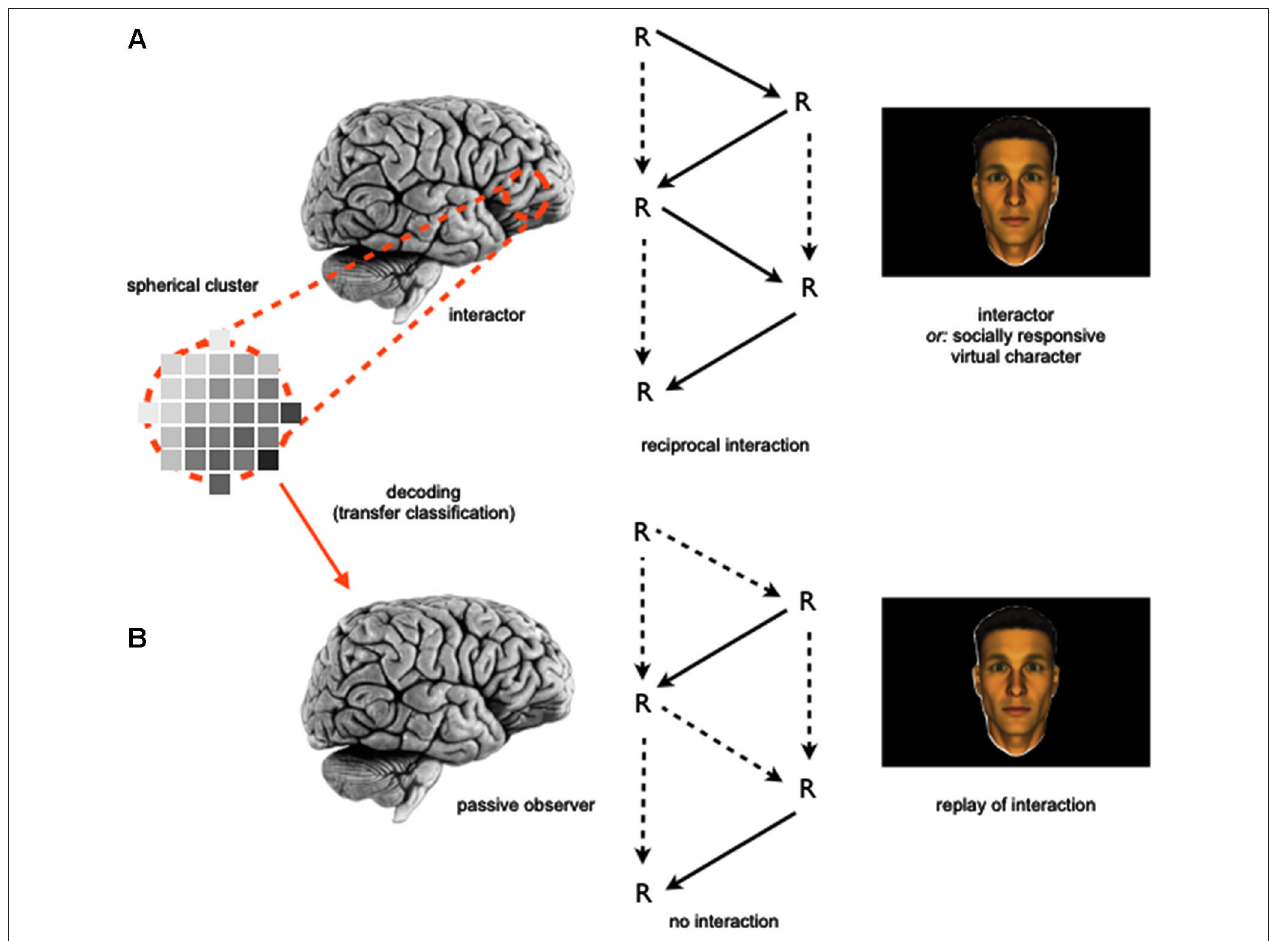
is trained to separate brain states obtained during a social interaction task. (B) The machine learning algorithm is then used to classify a separately obtained data set, which includes brain states measured during social